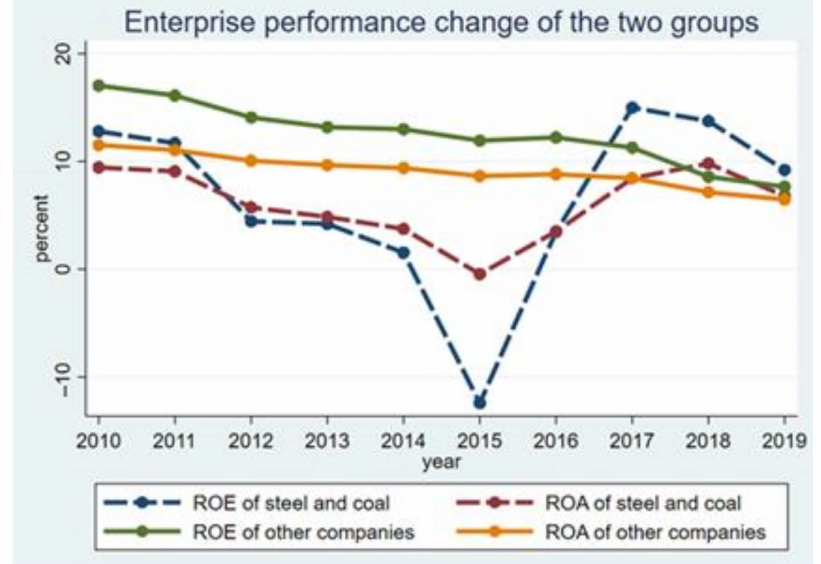
Figure 2. Changes in ROE and ROA of the two